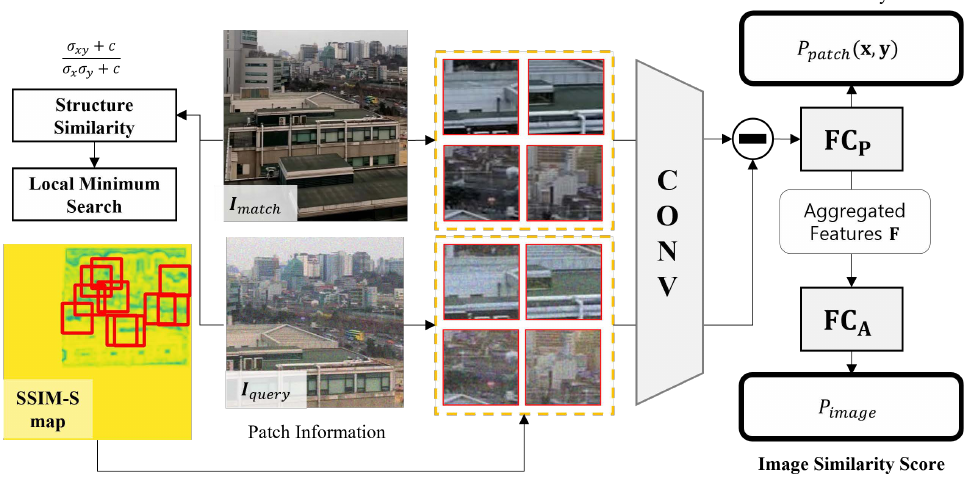
Figure 9. Image similarity siamese network between the matched database image I match and the query image I query . The architecture of [38] is employed for this CONV . In the figure, the SSIM-S map corresponds to structure term of